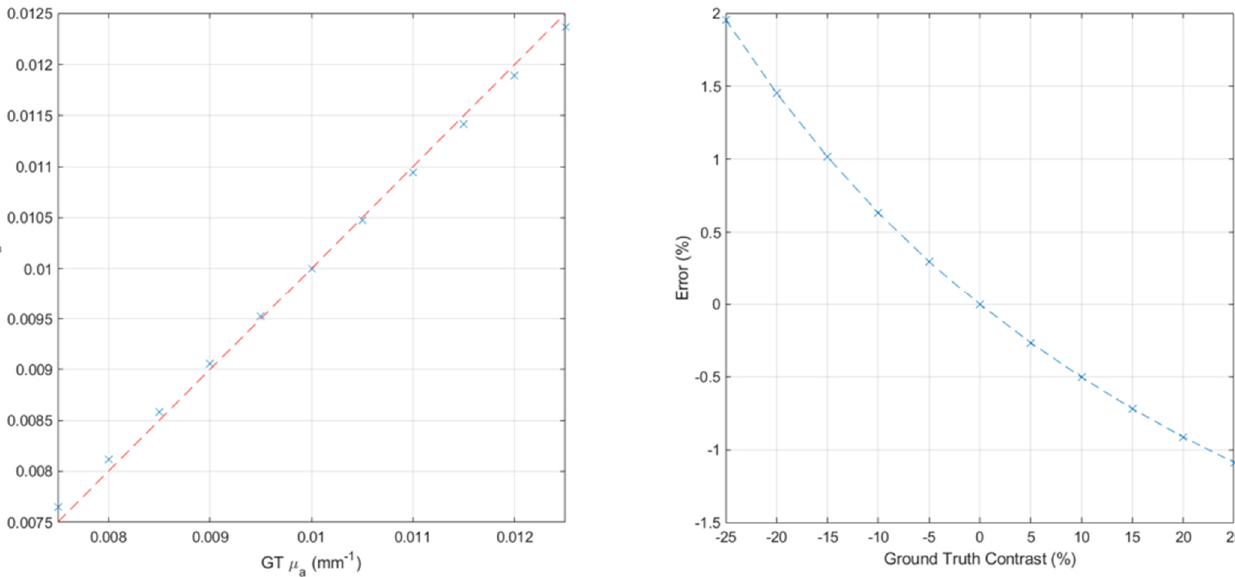
Figure 5. Homogenous slab simulations. The recovered absorption is compared to the mesh ground truth alongside the parameter recovery error for each simulation, determined using Equation (8).